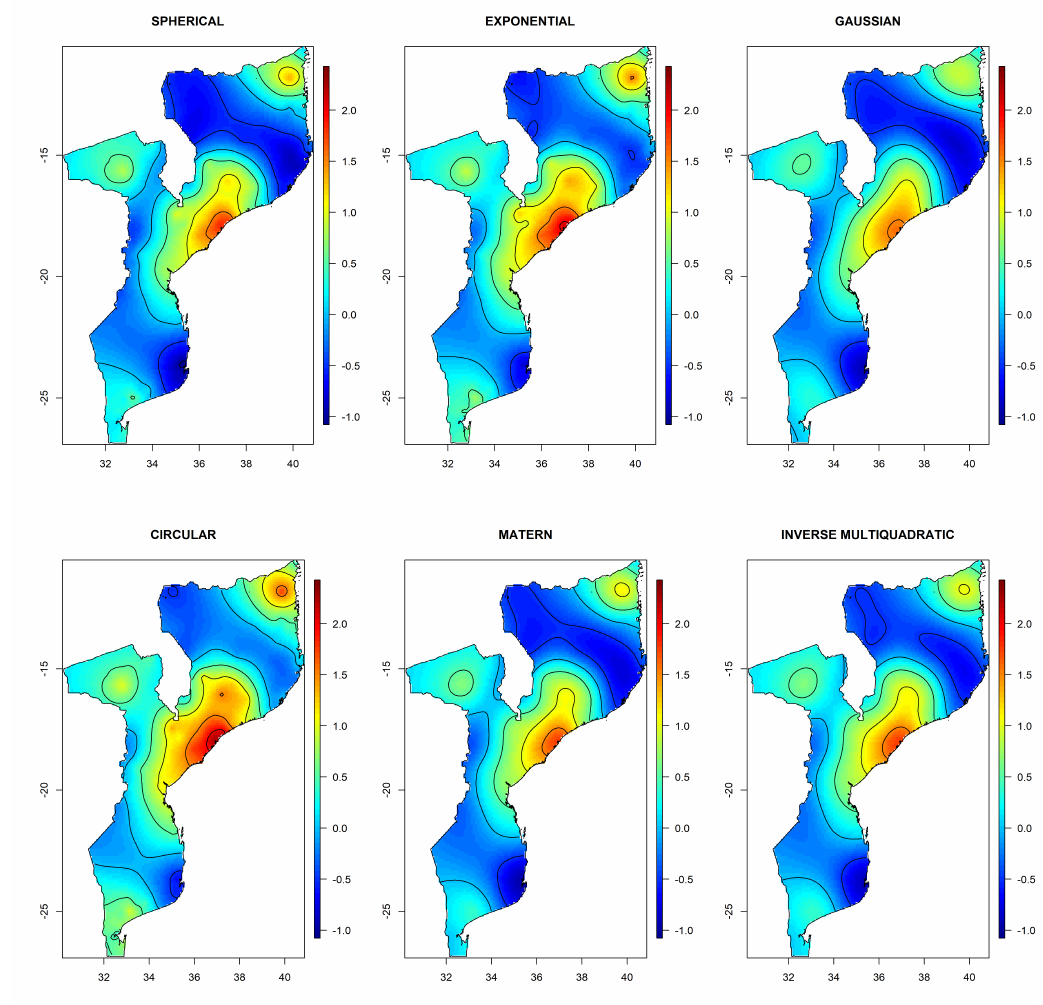
Figure 1. Image plots of the radial spline basis using the two stage-iterative estimation process with different covariance functions. The plotted radial spline basis is on natural log-odds scale. This illustrates the spatial variation of HIV risk in